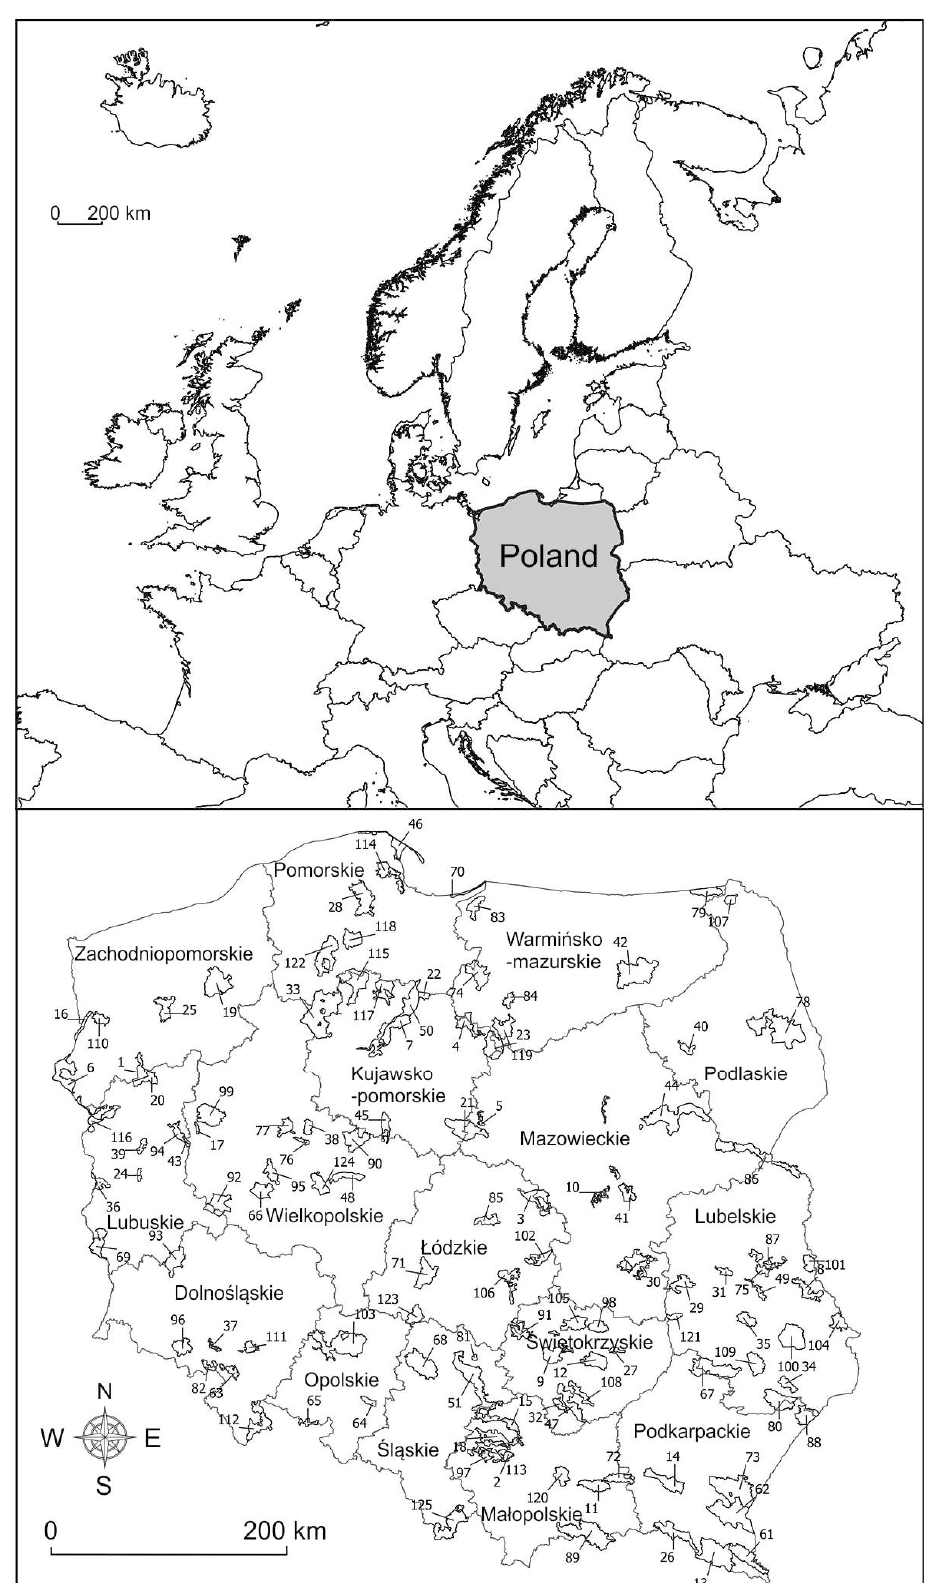
Figure 1. Landscape park network in Poland. 1—Barlinecki, 2—Biela ń sko-Tyniecki,